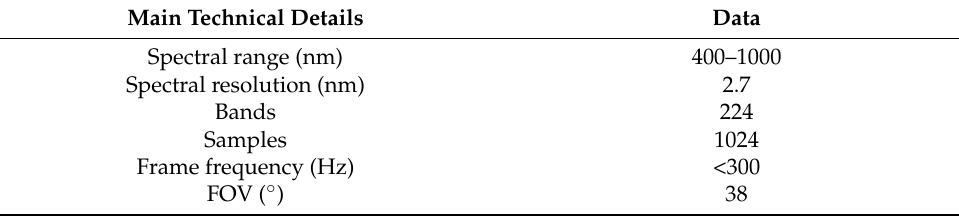
Table 2. Hyperspectral imager